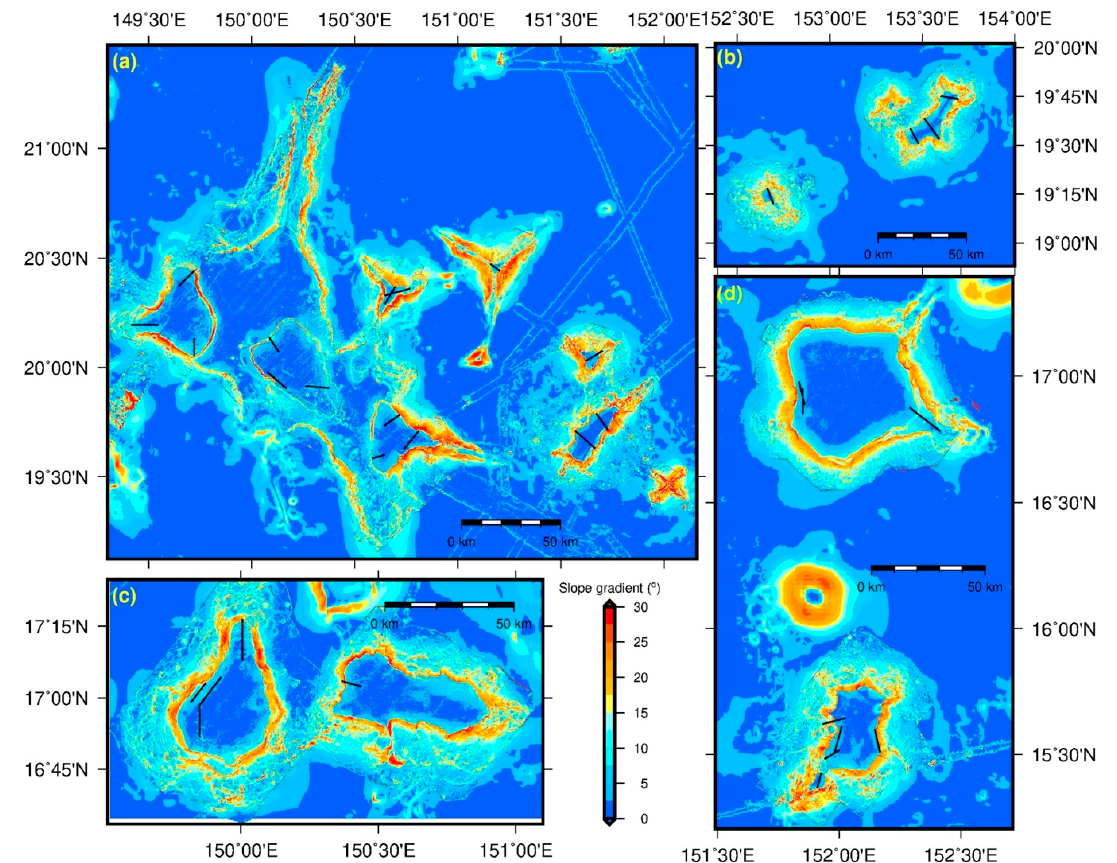
Figure 3. Multibeam-derived slope gradient maps of seamounts in the ( a ) northwest, ( b ) northeast, ( c ) southwest, and ( d ) south sectors of Figure 1b. Black lines are the transects of the DCS survey.